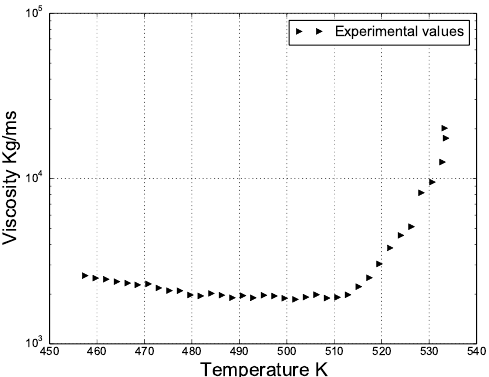
Figure 2. Viscosity of MDH30/PP in the dynamic temperature step mode.